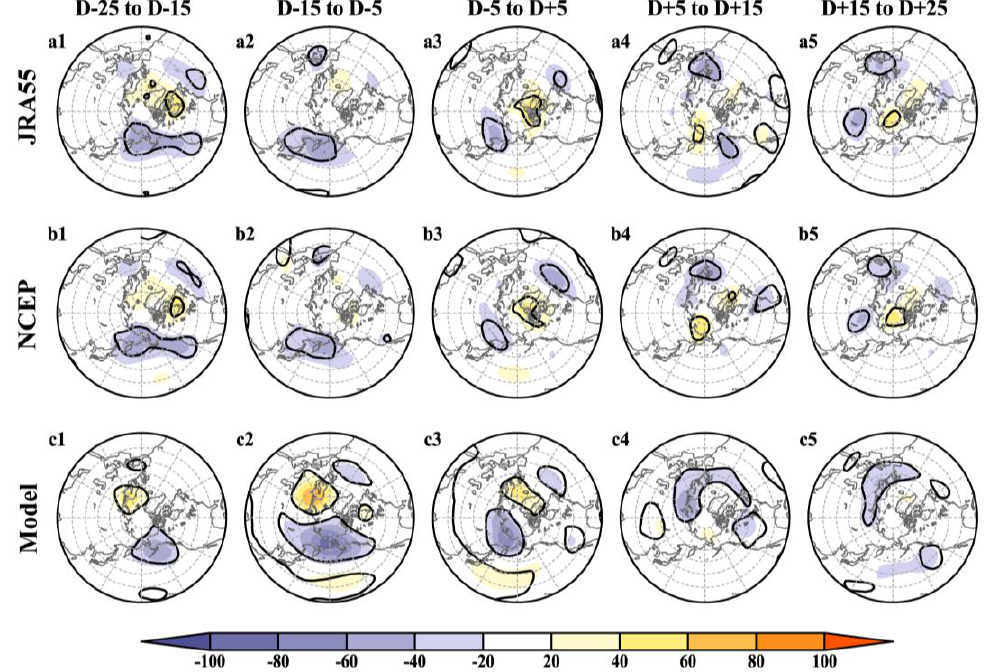
Figure 7. Composite of geopotential height anomalies (shadings; units: gpm) at 500 h Pa in ( a1–a5 ) the JRA55 reanalysis, ( b1–b5 ) the NCEP / NCAR reanalysis, and ( c1–c5 ) CESM1-WACCM during day − 25 to − 15 ( first column ), day − 15 to − 5 ( second column ), day − 5 to 5 ( middle column ), day 5 to 15 ( fourth column ), and day 15 to 25 ( fifth column ) relative to the SSW onset date. Black contours indicate that the composite height anomalies are significant at the 95% confidence level according to the t -test.